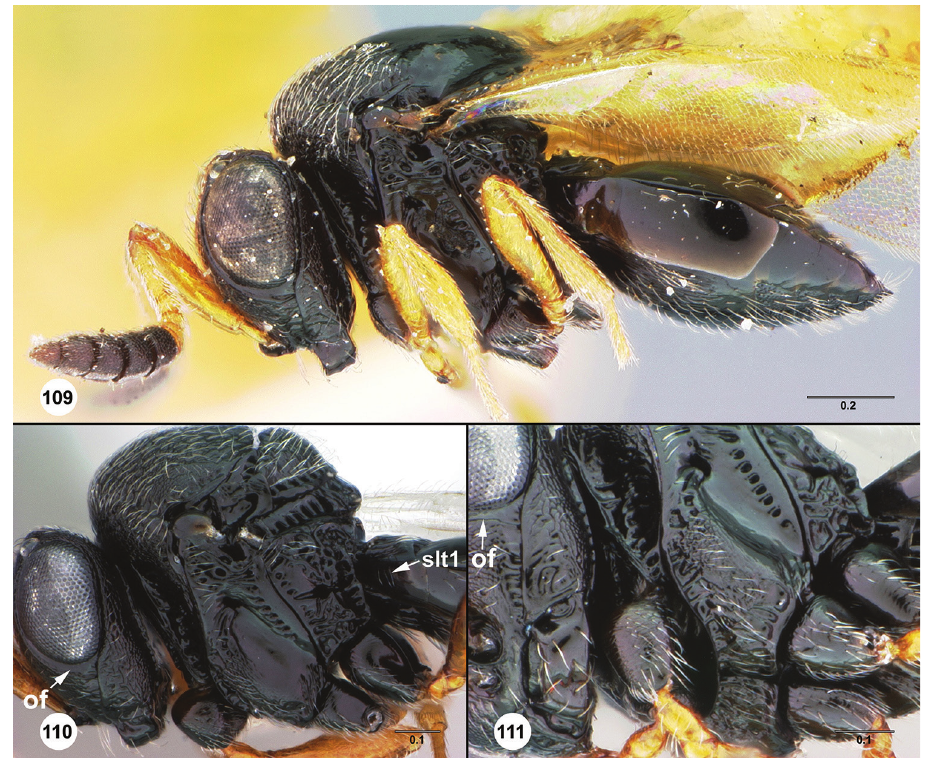
Figures 109–111. T. mitsukurii 109 female holotype (USNMENT00989031), head, mesosoma, meta- soma, lateral view 110 female (USNMENT00675722), head and mesosoma, lateral view 111 female (USNMENT00675722), head and mesosoma, ventrolateral view. Scale bars in millimeters. poorly defined to absent. Paracoxal sulcus in ventral half of metapleuron: indistin- guishable from sculpture to absent. Anteroventral extension of metapleuron: not ex- tending to base of mesocoxa. Metapleural epicoxal sulcus: absent or indistinguishable from sculpture; present as coarse rugae. Mesoscutal humeral sulcus: indicated by a line of cells. Median mesoscutal carina: absent. Macrosculpture of mesoscutum: rugulose. Pattern of mesoscutal microsculpture: uniform throughout. Mesoscutal suprahumeral sulcus: comprised of cells. Length of mesoscutal suprahumeral sulcus: about half the length of anterolateral edge of mesoscutum. Parapsidal line: present. Notaulus: extend- ing at least 1/3 length of mesoscutum. Median protuberance on anterior margin of mesoscutellum: absent. Protruberance on anterior margin of mesoscutellum directly posterior to notaulus: absent. Shape of dorsal margin of anterior lobe of axillar cres- cent: round. Sculpture of anterior lobe of axillar crescent: absent. Posterodorsal margin of axillular carina: round. Area bounded by axillar crescent: smooth. Macrosculpture of mesoscutellum: rugose throughout. Microsculpture on mesoscutellum: present throughout. Median mesoscutellar carina: absent. Setation of posterior scutellar sulcus: present. Form of metascutellum: coarsely rugose. Metanotal trough: foveate,